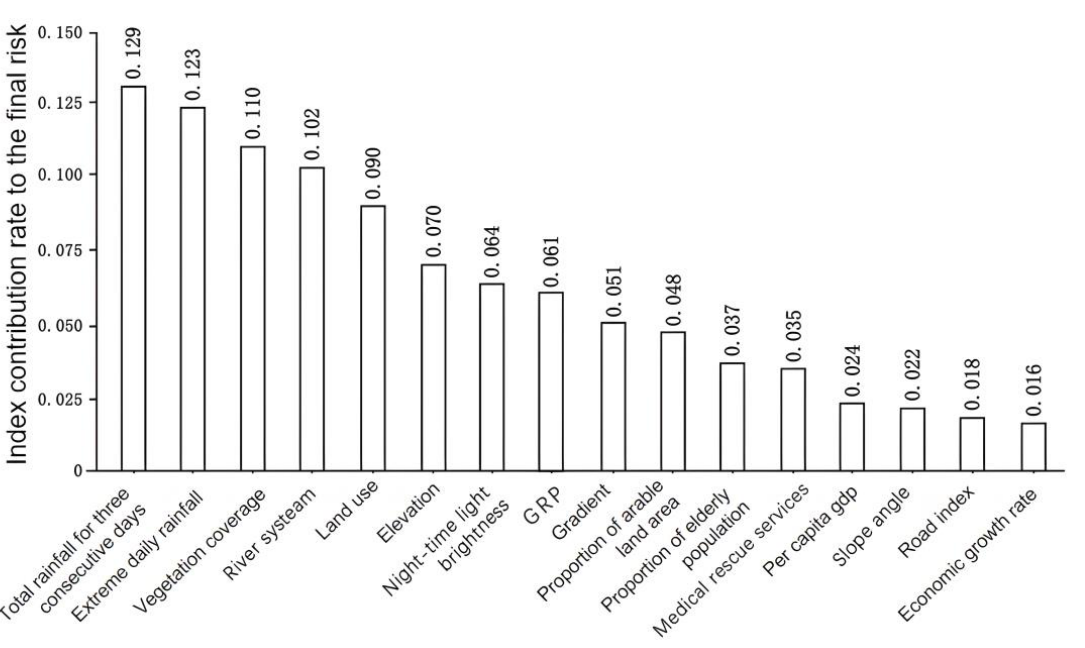
Figure 4. Ranked contribution rates of assessment indicators.